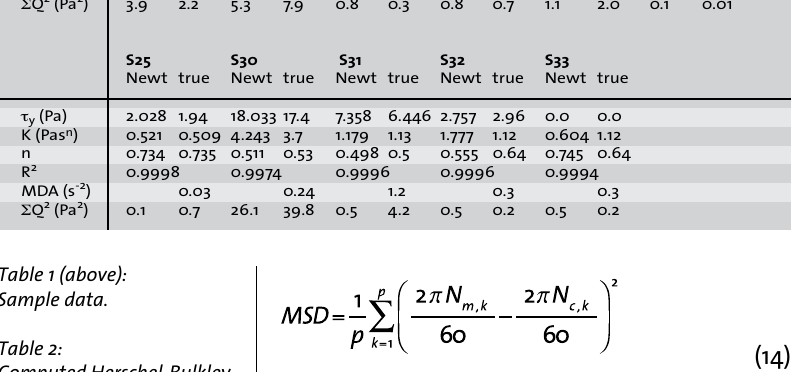
Table 1 (above): Sample data. Table 2: Computed Herschel-Bulkley rheological parameters with true and Newtonian shear rates, for the samples con-